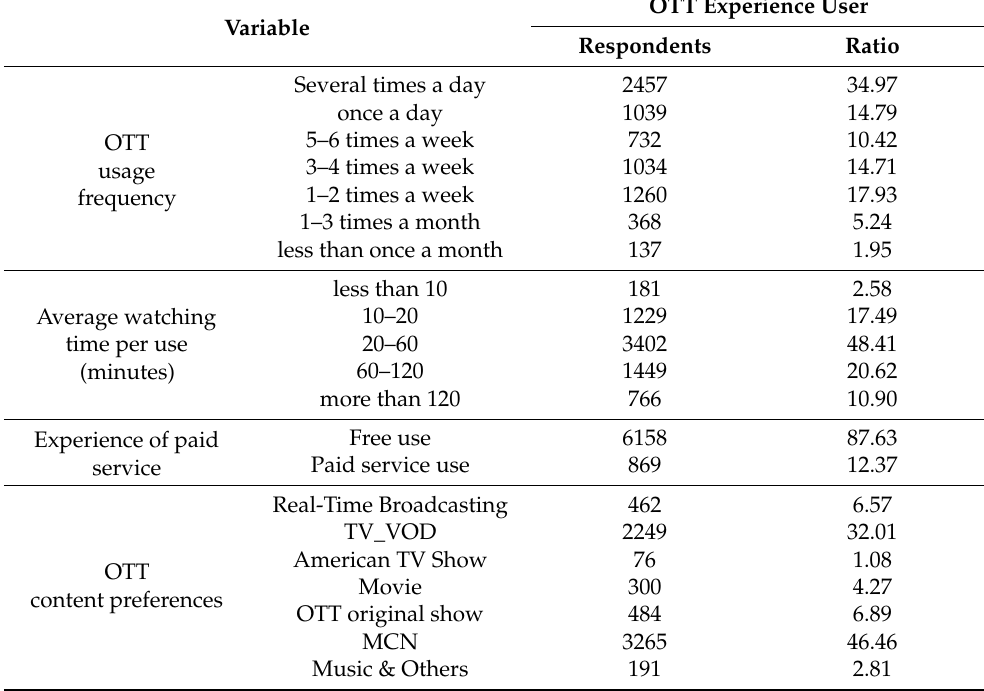
Table 2. OTT usage patterns of